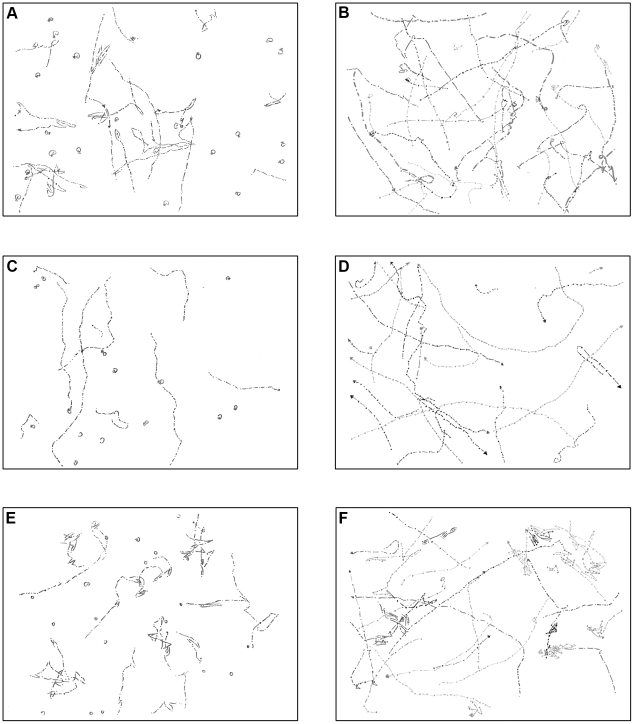
Motility defect of the cheR1 mutant as observed by light microscopy.(A, B) The wild-type (A, PA01 wt control and B, PA14 wt) exhibits a straight forward - short backup/reversal - straight forward mode of swimming. (C, D) The cheR1 mutant (C, PA01 and D, PA14) changes its direction less frequently than the wild-type and tends to swim straight. (E, F) The cheR1 mutant complemented with pUCP20:cheR1 in trans (E, PA01 and F, PA14) is oscillating rapidly between forward and backward swimming.